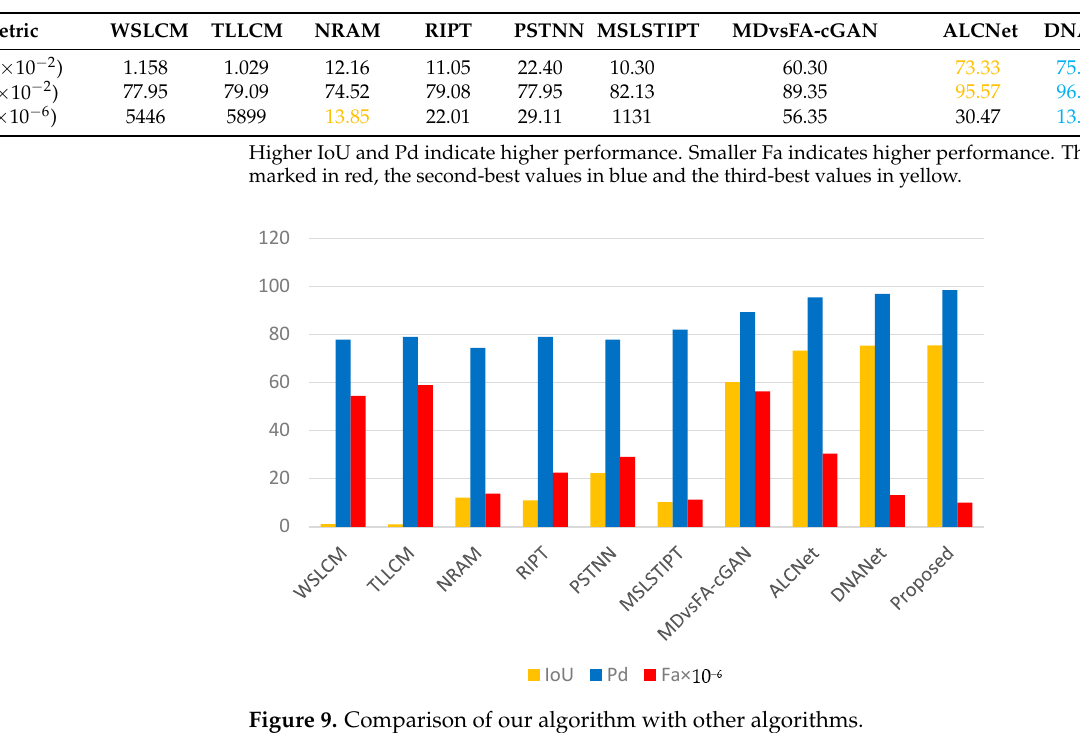
Figure 9. Comparison of our algorithm with other algorithms.